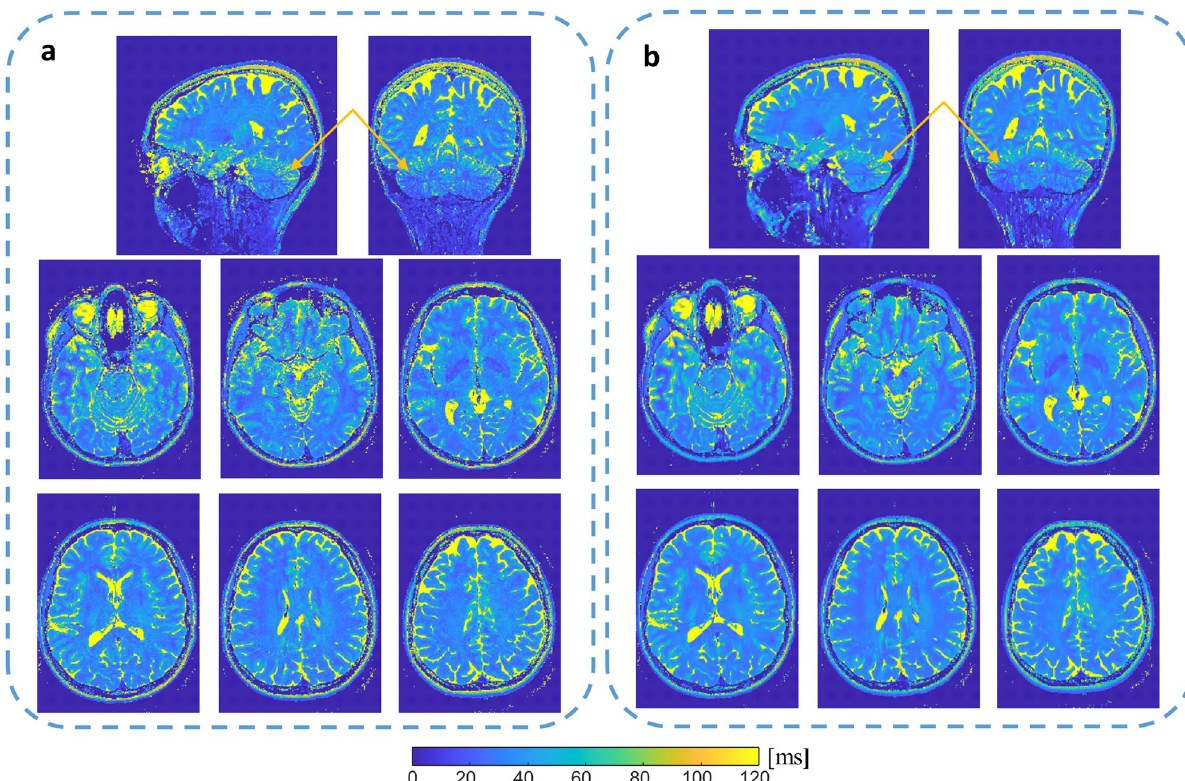
Figure 7. Human whole-brain T 2 maps with a 0.85 mm isotropic voxel. ( a ) without denoising, ( b ) with denoising, based on DnCNN model for Gaussian noise removal. Arrows point to the cerebellum region, which especially benefits from denoising. Top row, Sagittal and Coronal planes. Bottom two rows, six slices of the Axial plane, at 10 mm